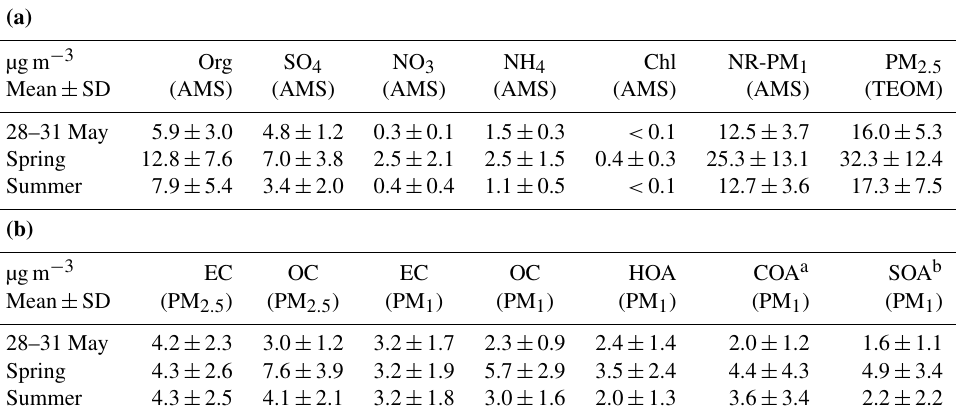
Table 1. (a) Species concentrations from AMS and total PM 2 . 5 mass from TEOM; (b) EC, OC and organic aerosol constituent concentrations (AMS PMF analysis); average concentrations during the traffic counting period (28–31 May 2013) and seasonal averages (Spring: March– May 2013, Summer: May–July 2013 ) based on Lee at al. (2015) at the Mong Kok